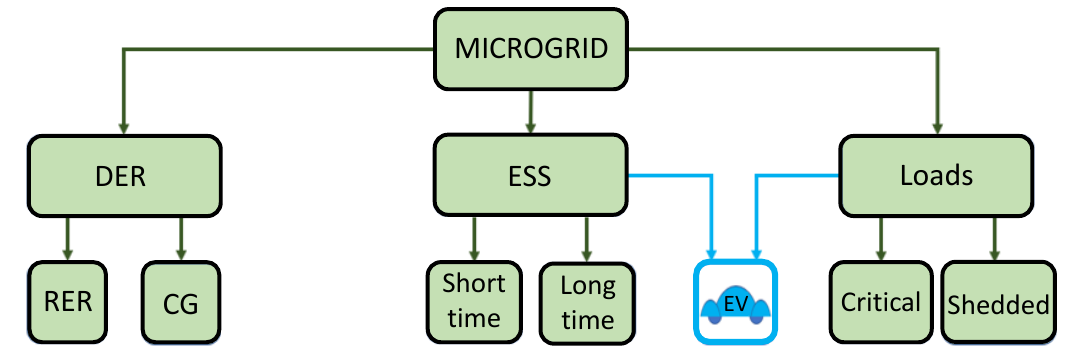
Figure 3. Microgrid components. Table 2. Sustainable energy systems in